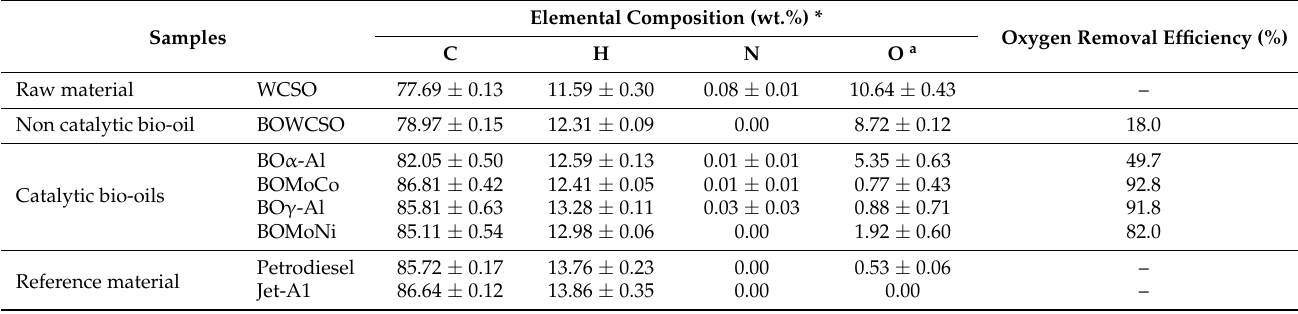
Table 3. Elementary composition of raw material, petrodiesel, Jet-A1, and bio-oils that were obtained from catalytic and non-catalytic micropyrolysis